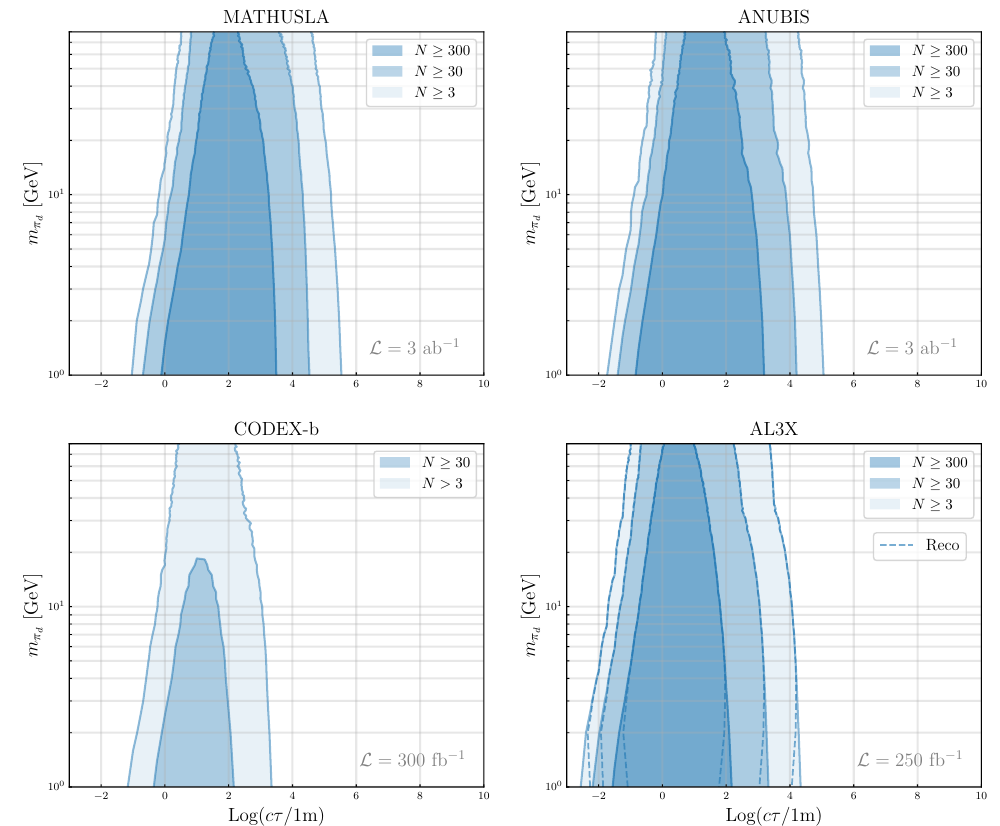
Figure 5 . Experimental contours of detecting N > 3 (light blue), 30 (blue), 300 (dark blue) for the transverse experiments MATHUSLA, AL3X, CODEX-b, and ANUBIS. The dashed lines in the bottom right plot include the reconstruction (reco) efficiency (cid:15) 6 = 1 . These contours assume a fixed mediator mass of M X = 1